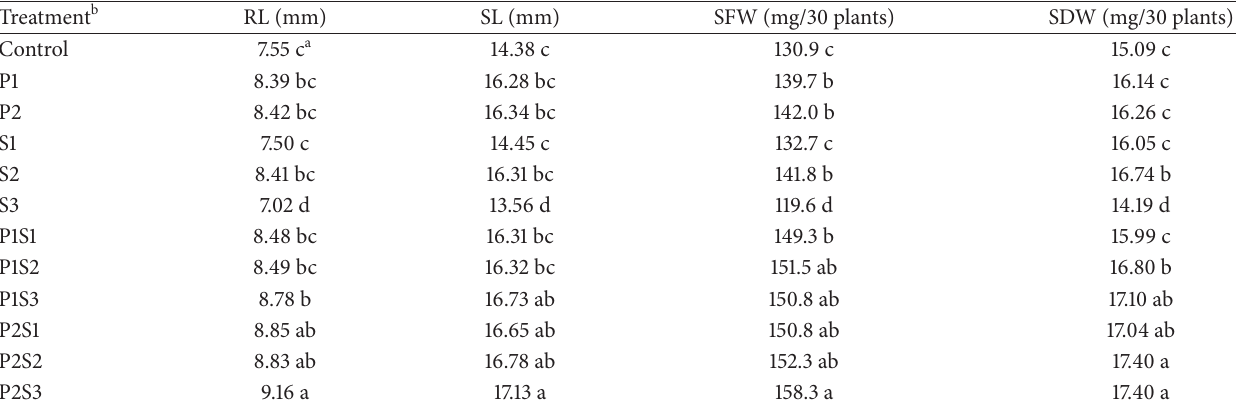
Table 5: Effects of coating agents on seedling growth of MSk326 under drought stress. Treatment